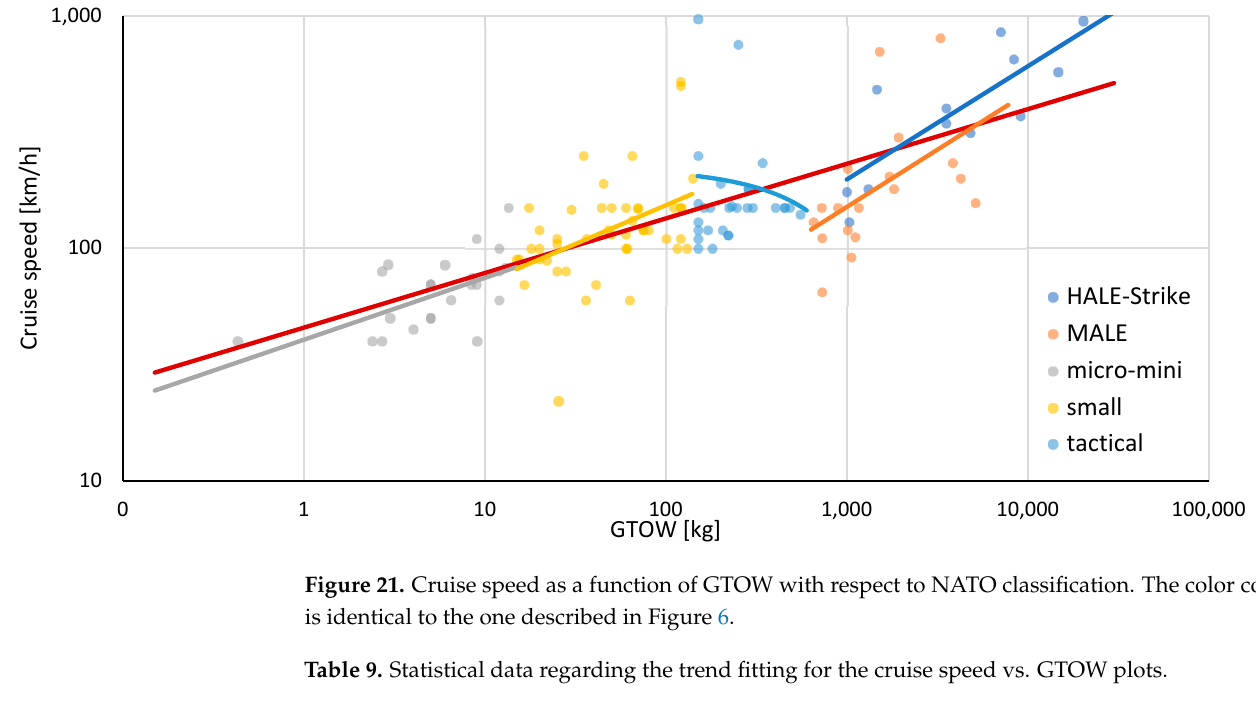
Figure 20. Cruise speed as a function of GTOW for the general category.